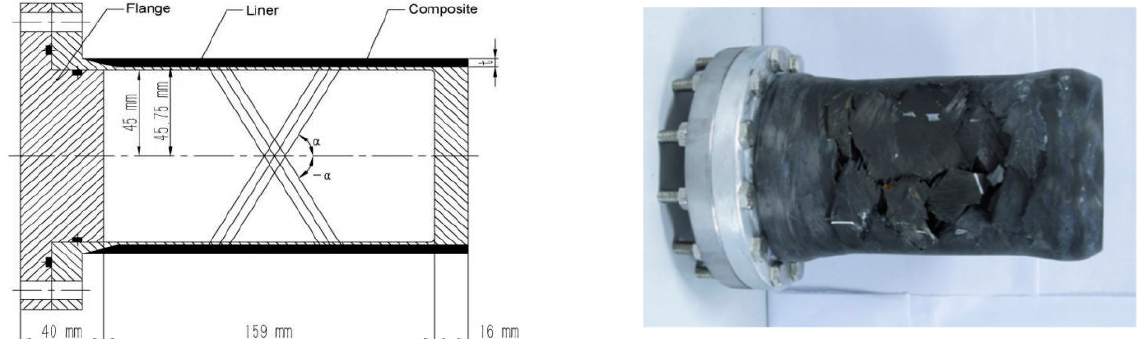
Figure 3. Hydrostatic damage test of carbon fiber composite pressure hull with aluminum liner [47].